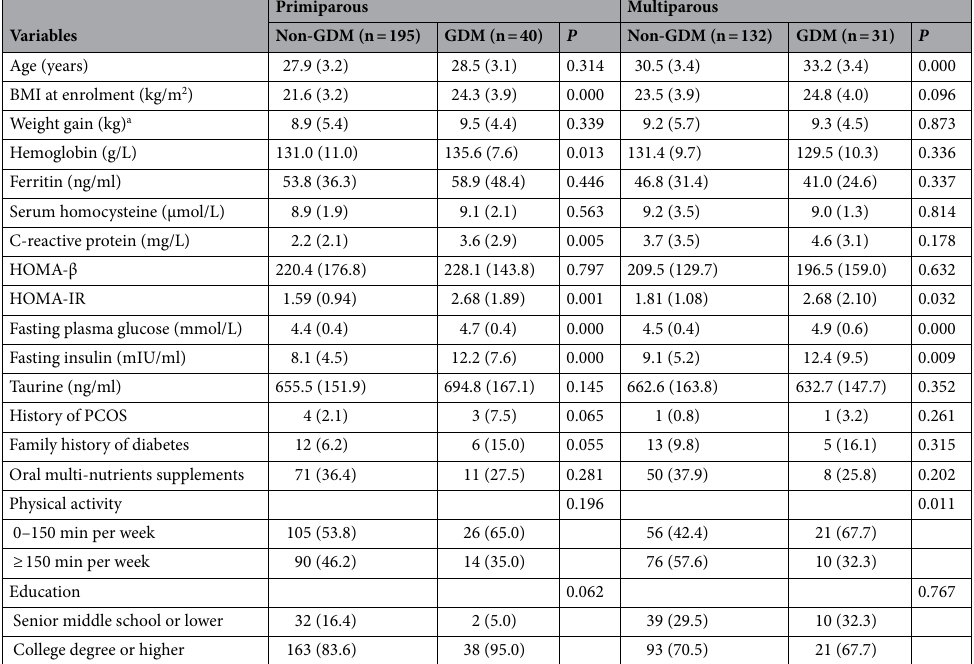
Table 2. Comparison of basic characteristics between GDM group and non-GDM group in primiparous and multiparous women. BMI body mass index, HOMA-IR homeostasis model assessment—insulin resistance, HOMA-β homeostasis model assessment-β, PCOS polycystic ovary syndrome. a Represents weight gain from enrolment to the 75-g oral glucose tolerance test.